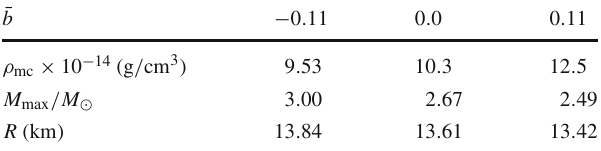
Fig. 14 Variation of the stellar mass M / M (cid:2) as a function of the radius of the star R for the three-form field photon stars in the presence of a Higgs-type potential, for ¯ a = 0 . 007 and three different values of the constant ¯ b : ¯ b = 0 (dashed curve), ¯ b = − 0 . 11 (dotted curve), and ¯ b = 0 . 11 (dot-dashed curve), respectively. The solid curve shows the mass–radius relation for photon stars in standard general relativity Table 4 The maximum masses and the corresponding radii for three- form field photon stars in the presence of a Higgs-type potential, for ¯ a = 0 . 007, and for different values of ¯